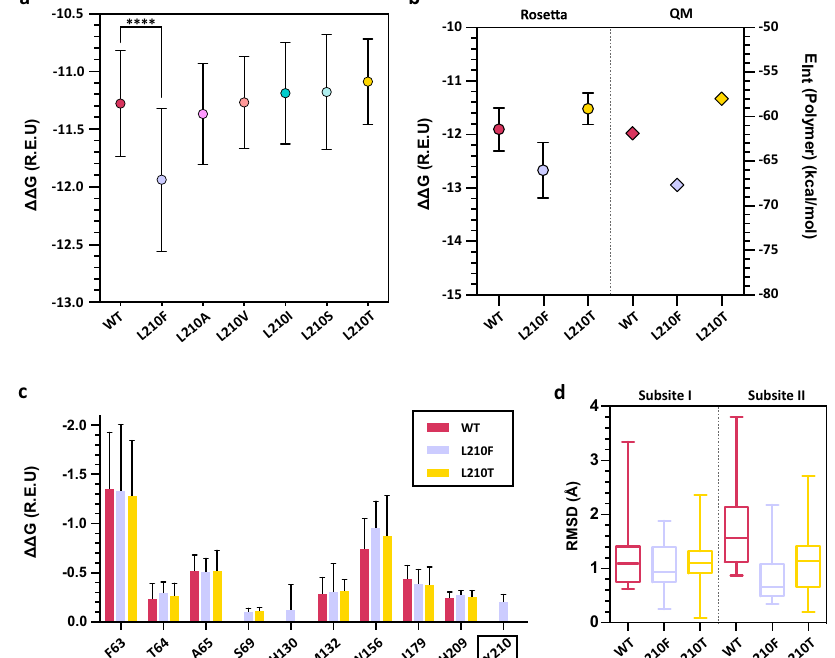
Fig. 4 | Rosetta ligand docking and quantum chemical calculations based on densityfunctionaltheory(DFT)ofPHL7andselectedvariantsinpositionL210. a Average Rosetta free binding energy ( ΔΔ G) (mean±SD) of the cluster that best represented the optimal binding poses of EMT ( n =32 independent calculations). The position of the terephthalic ring of EMT in the most populated cluster super- imposes well with the terephthalic ring in the PHL7×TPA cocrystal structure. One- wayTuckeytestwasconductedtoassessiftheaverage ΔΔ Gofthemostpopulated clusterwassigni fi cant(****= p <0.0001).Notethatnormaldistributionwasassumed as the number of data points did not allow for a normality test. b Comparison of Rosetta ’ saverage ΔΔ G(left)(mean±SDfor n =10independentcalculations)andof interactionenergiesE Int betweenEMTandtheproteinfromDFTcalculations(right, n =1).Regardingthe fi rst,wereportthemean±SDinterface_delta_Xscoreofthe10